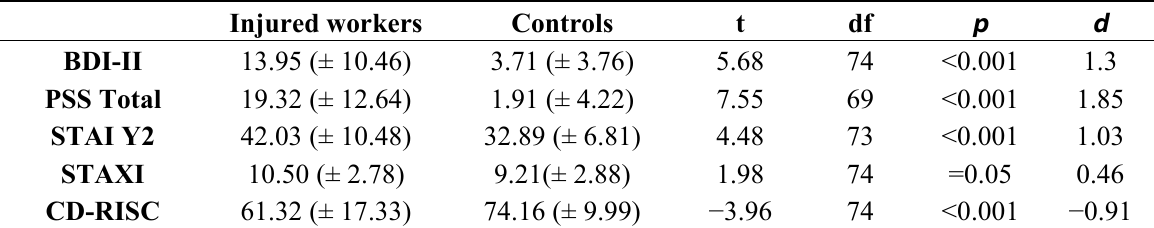
Table 2. Mean self-report questionnaire scores and differences between groups. Values are mean ±